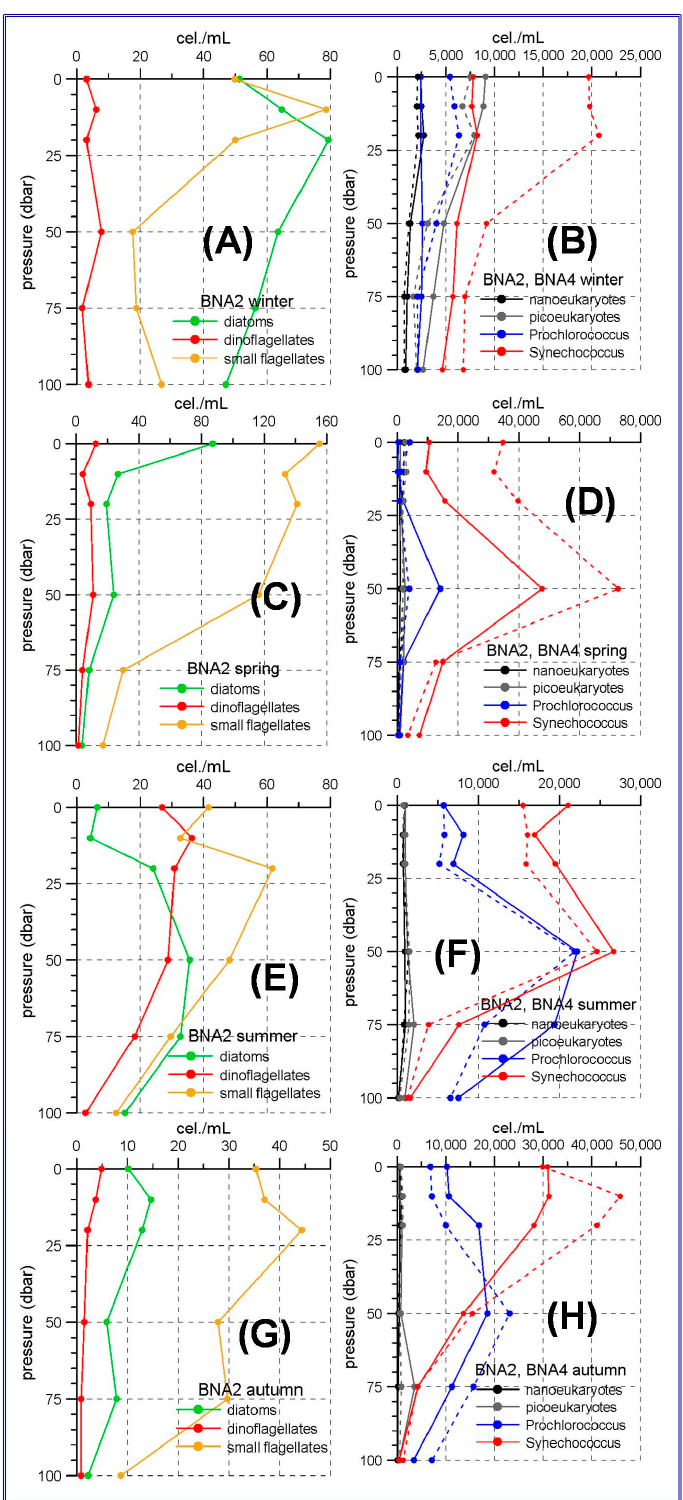
Figure 5. ( A ) shows the winter average vertical distribution of diatom abundances (green line), small flagellates (yellow line) and dinoflagellates (red line) at station BNA2. ( B ) shows the winter average vertical distribution for nanoeukaryotes (black line), picoeukaryotes (grey line), Prochlorococcus (blue line) and Synechococcus (red line) at the BNA2 station (solid line) and BNA4 station (dashed line). ( C , D ) are the same for spring, ( E , F )for summer and ( G , H ) for autumn.